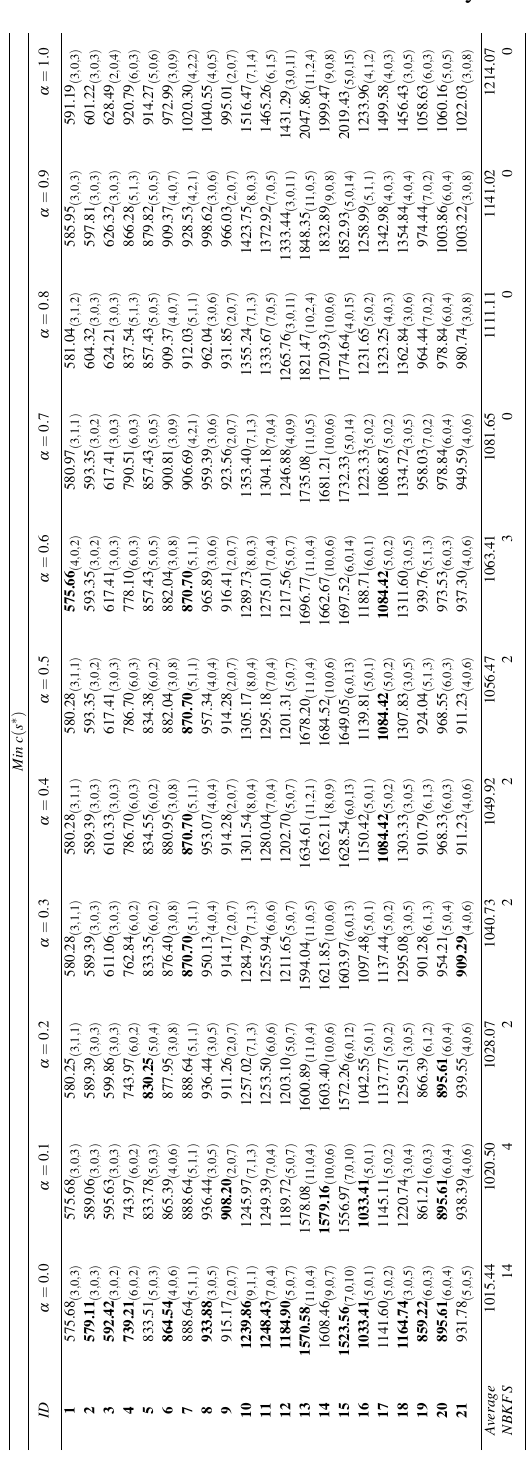
Table 2: Results for 21 instances TTRP with fuzzy